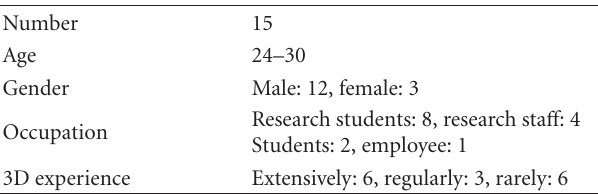
Table 1: Psychographic